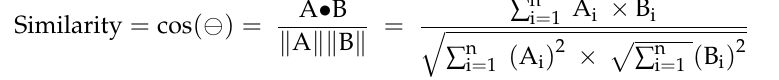
Figure 5. Expertise factor.